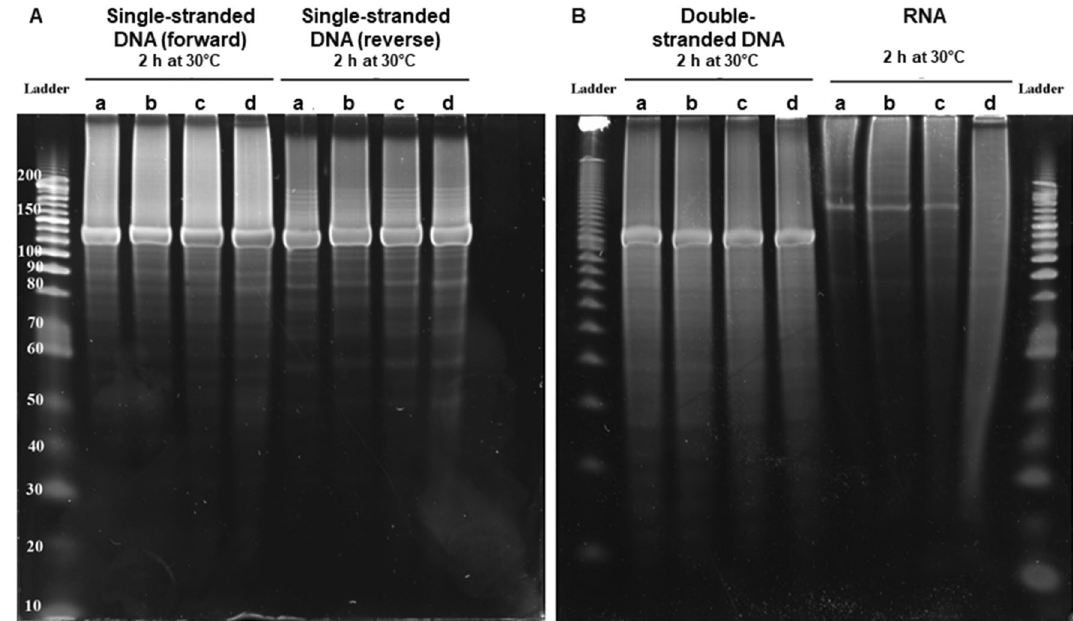
Figure 4. Nuclease activity on various types of nucleic acids of expressed Tupanvirus protein (TupBlac) as assessed by dPAGE. Denaturant polyacrylamide gel electrophoresis (12% dPAGE) of nuclease activity on synthetic (+) and (−) single-stranded DNAs (130 nucleotide-long) ( A ), synthetic double-stranded DNA ( B ) (see Supplementary Table 3), or Escherichia coli RNA ( B ). Each part A and B of the figure correspond to different gels. No treatment (a); buffer (b); succinate dehydrogenase enzyme produced and purified by the same process and collected in the same fractions as Tupanvirus beta-lactamase TupBlac, used as negative control (c); Tupanvirus beta-lactamase TupBlac